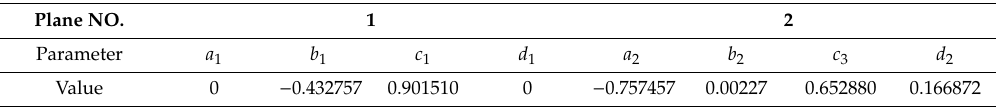
Table 1. Parameters of the laser planes of the transmitter station employed for verification testing, where a j , b j , c j , and d j are the parameters of Equation (1). Plane NO. 1 2 Parameter a 1 b 1 c 1 d 1 a 2 b 2 c 3 d 2 Value 0 − 0.432757 0.901510 0 − 0.757457 0.00227 0.652880